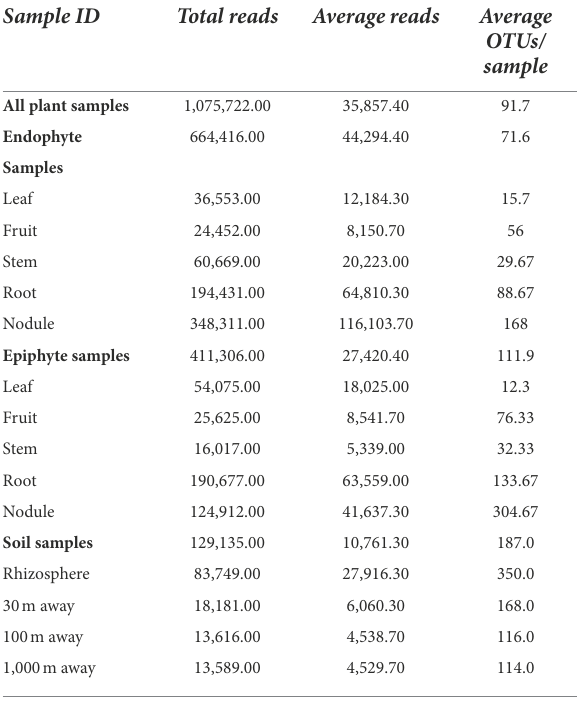
TABLE 1 Summary of sequencing results for C. myrtifolia phytomicrobiome, rhizosphere and surrounding associated